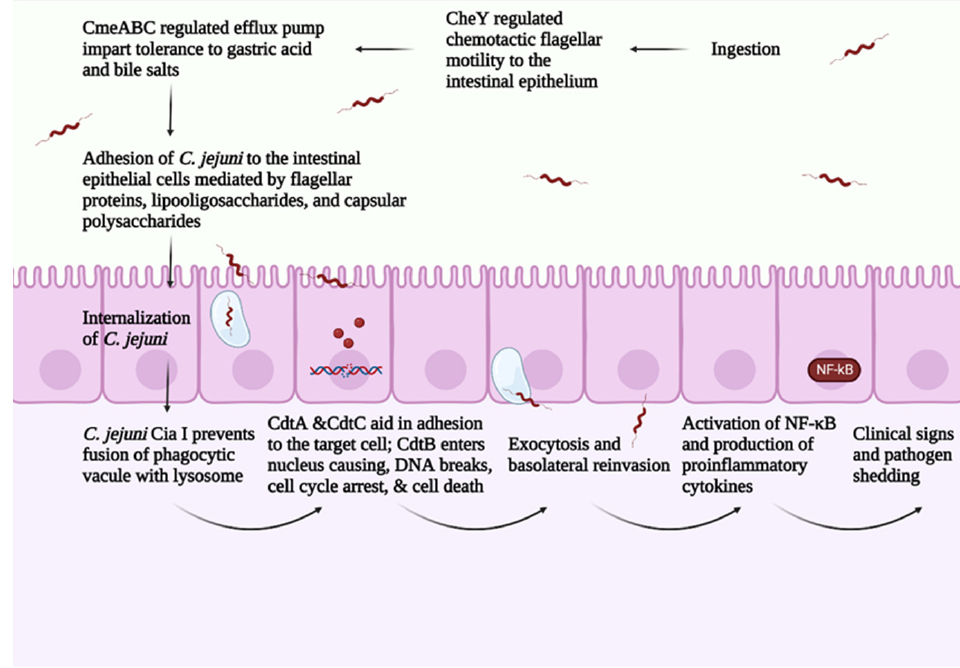
Figure 2. Overview of C. jejuni pathogenesis. Created with Biorender.com (20 September 2022).